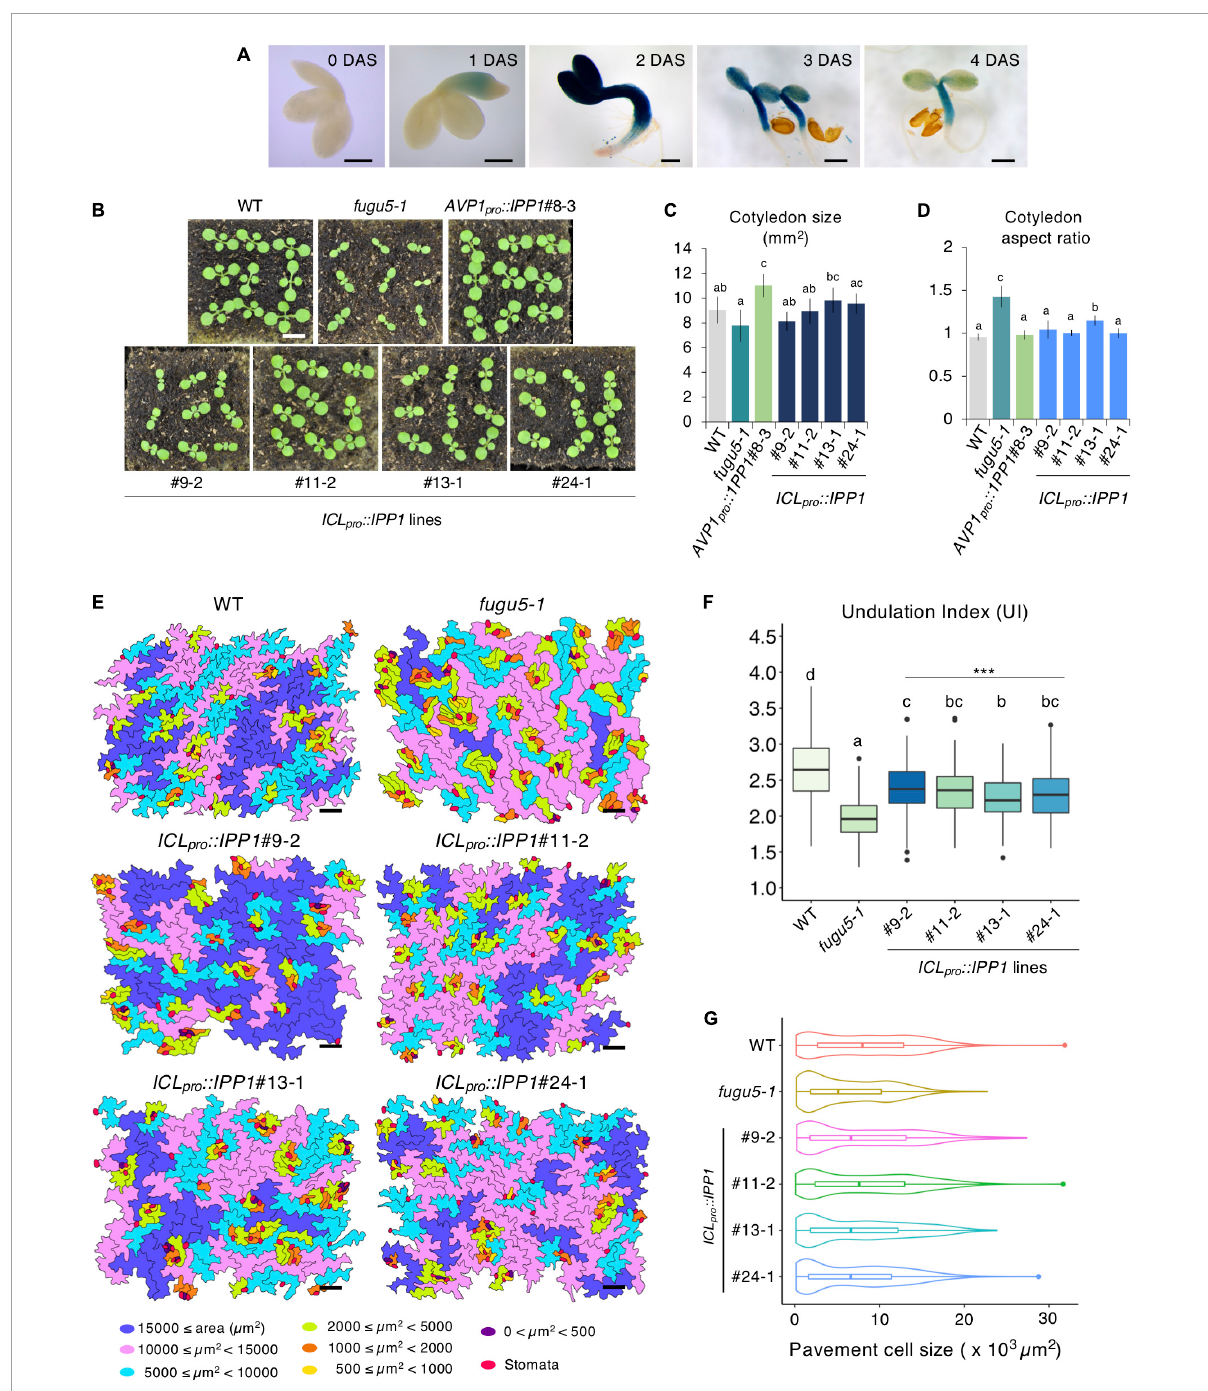
FIGURE4 Effect of developmental stage-specific removal of inorganic pyrophosphate (PPi) on plant development. (A) Time course of GUS expression in fugu5-1 ICL pro ::GUS . Scale bar = 200 µ m (at 0-, 1-, 2 DAS); Scale bar = 500 µ m (at 3 and 4 DAS). (B) Gross morphology of the wildtype (WT), fugu5-1 , AVP1 pro ::IPP1 #8-3, and ICL pro ::IPP1 lines. Photographs of 10-day-old plants grown on rockwool. Scale bar = 5 mm. (C) Cotyledon size and (D) aspect ratio of six cotyledons at 25 DAS. Data are means ± SD. Each character represents a significant difference at p < 0.05 (Tukey’s HSD test). (E) PCs in representative scanning electron microscopy (SEM) images of the WT, fugu5-1 , ICL pro ::IPP1 #9-2, ICL pro ::IPP1 #11-2, ICL pro ::IPP1 #13-1, and ICL pro ::IPP1 #24-1 lines were traced and color-coded based on their size. Scale bar = 100 µ m. (F) Box-plot represents undulation index (UI) of PCs ( n = 180 PCs from six cotyledons) at 25 DAS. The boxes of lower and upper are the first and third quantiles, the line in the boxes is the median and whiskers are maximum and minimum values. Each character represents a significant difference at p < 0.05. ***Significant difference compared to fugu5-1 at p < 0.001 (Tukey’s HSD test). (G) Violin plots of the size distribution of PCs, excluding stomata ( n = 480 cells from six cotyledons). DAS, days after seed